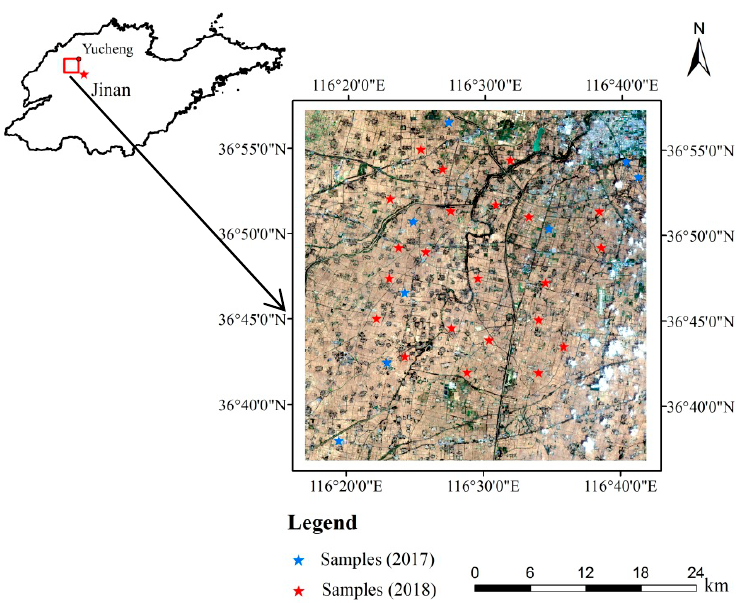
Figure 1. Study site, Yucheng County, Shangdong Province, China.